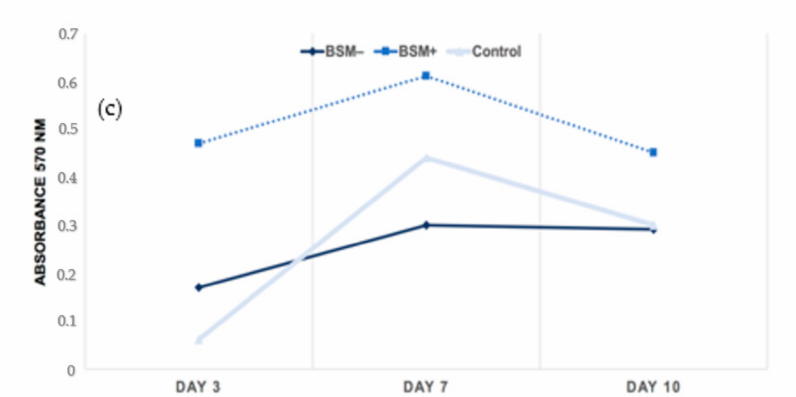
Figure 3. Tendency through the period of 3, 7 and 10 days within groups BSM − (cerabone ® ), BSM+ (cerabone ® Plus) and the control (HOB alone). ( a ) Cell viability, ( b ) migration ability, ( c ) proliferation rate.